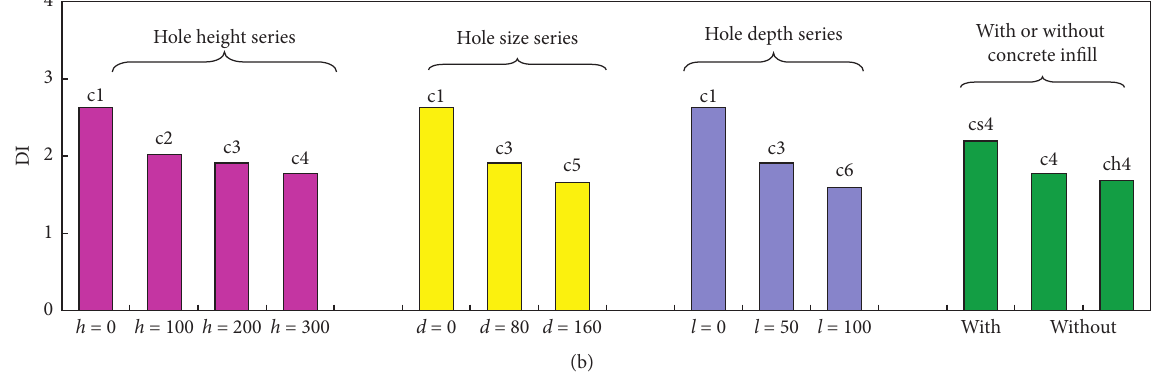
Figure 12: Ductility index (DI) of opening CFST columns. (a) Square section. (b) Circular section.